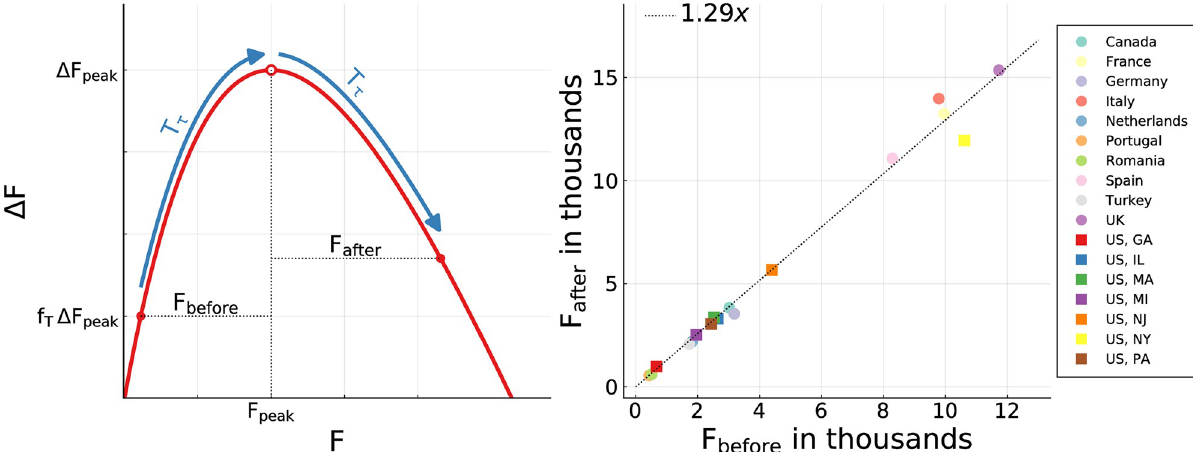
Fig 5. Fatalities before and after the peak—data. The observed numbers of fatalities F before and F after incurring over a time span T peak of an epidemic outbreak. Left : Procedure illustration. See the Methods Section for the determination of T τ . Right : All observed ratios F after / F before are close to 1.3. The linear fit corresponds to a linear regression with fixed intercept ( R 2 = 0.987). Per time, on average 30% more death incur after the peak.